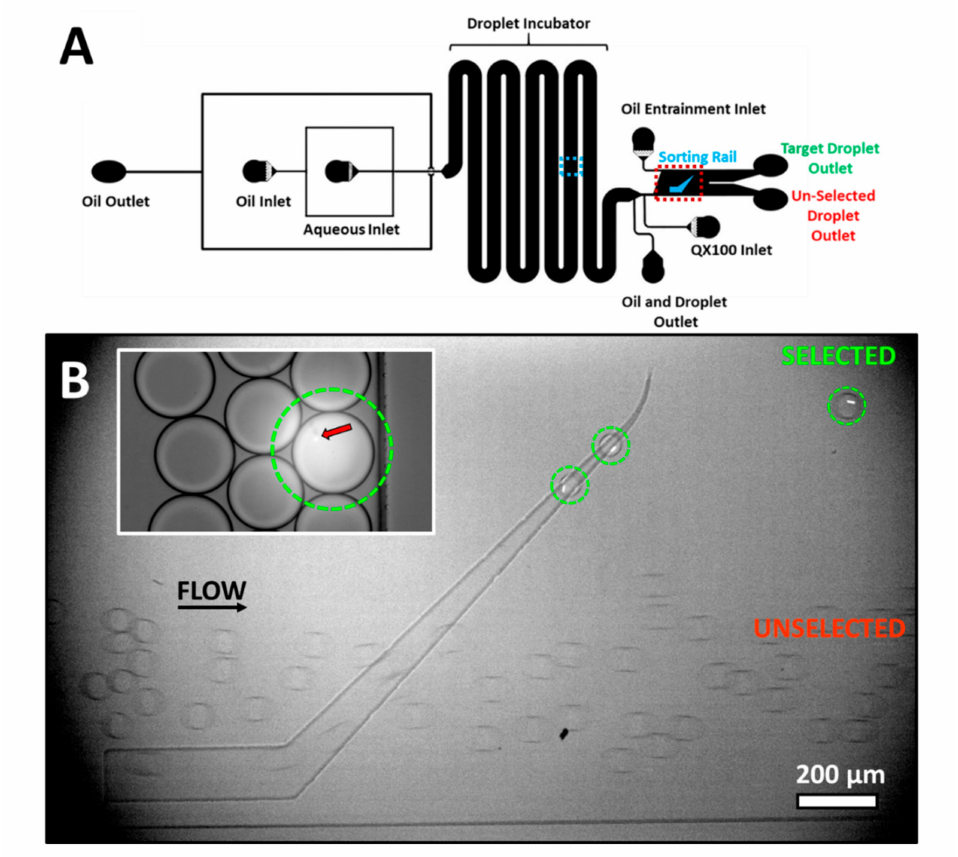
Figure 3. ( A ) Rail device channel geometry. The location of the images in ( B ) are shown. Location of droplet irradiation is indicated by a blue dashed rectangle and the sorting rail is highlighted by a dashed red rectangle. ( B ) Droplets containing fluorescent beads, circled in green, were previously irradiated with light. Irradiated droplets have lower pH and hence higher interfacial tension. They follow the rail upwards and leave at a higher lateral position toward the selected exit. Other droplets are immediately pushed o ff the rail by the flow of oil toward the unselected exit. Inset: A droplet circled in green was irradiated prior to sorting. Neighboring droplets are also partially irradiated. The red arrow indicates a fluorescent